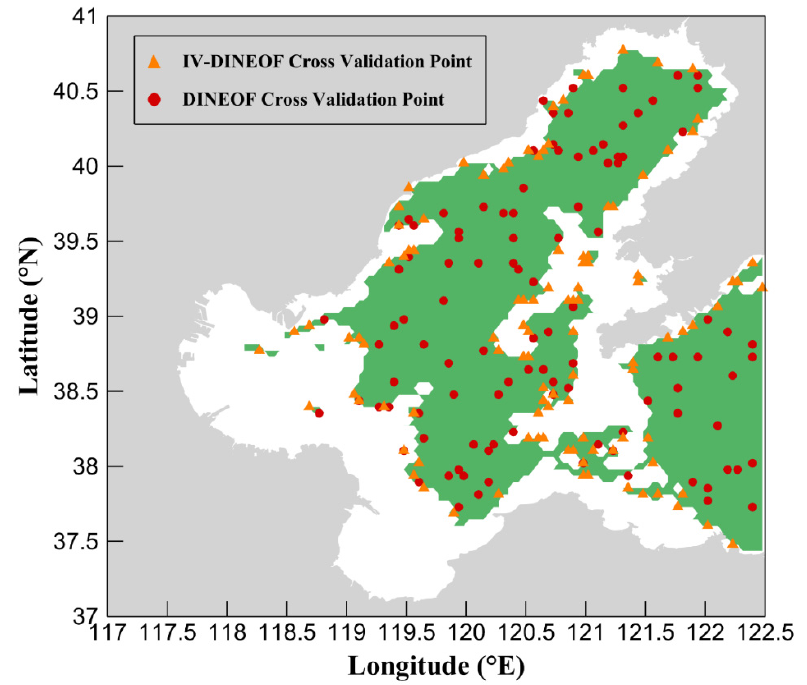
Figure 1. Comparison of cross-validation points among different algorithms (Gray area represents land, white area represents missing data points, and green area represents valid data points).